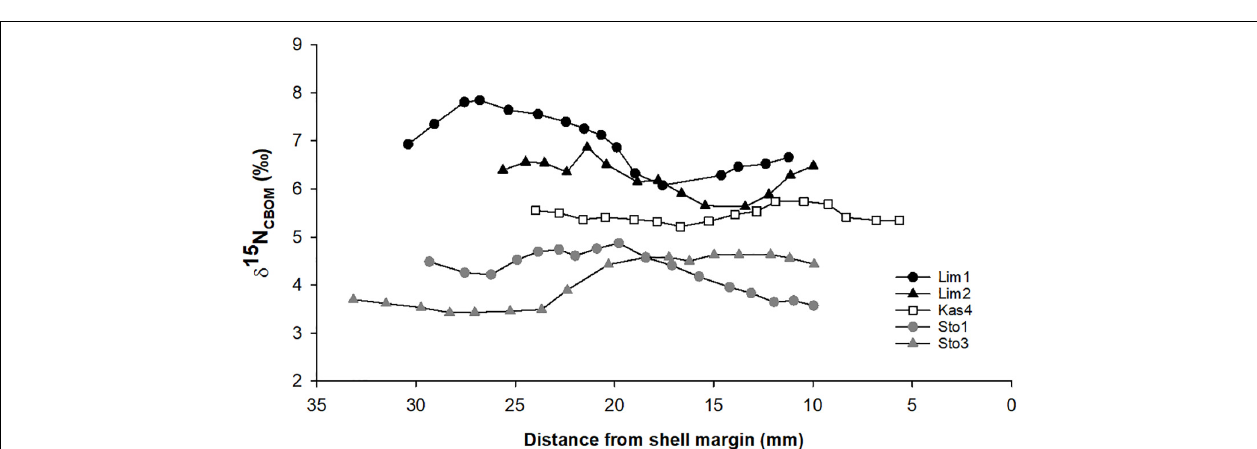
FIGURE 6 | High-resolution δ 15 N CBOM values of Pinna nobilis shells collected at Lim Bay (Lim1 and Lim2), Kaštela Bay (Kas4), and Mali Ston Bay (Sto1 and